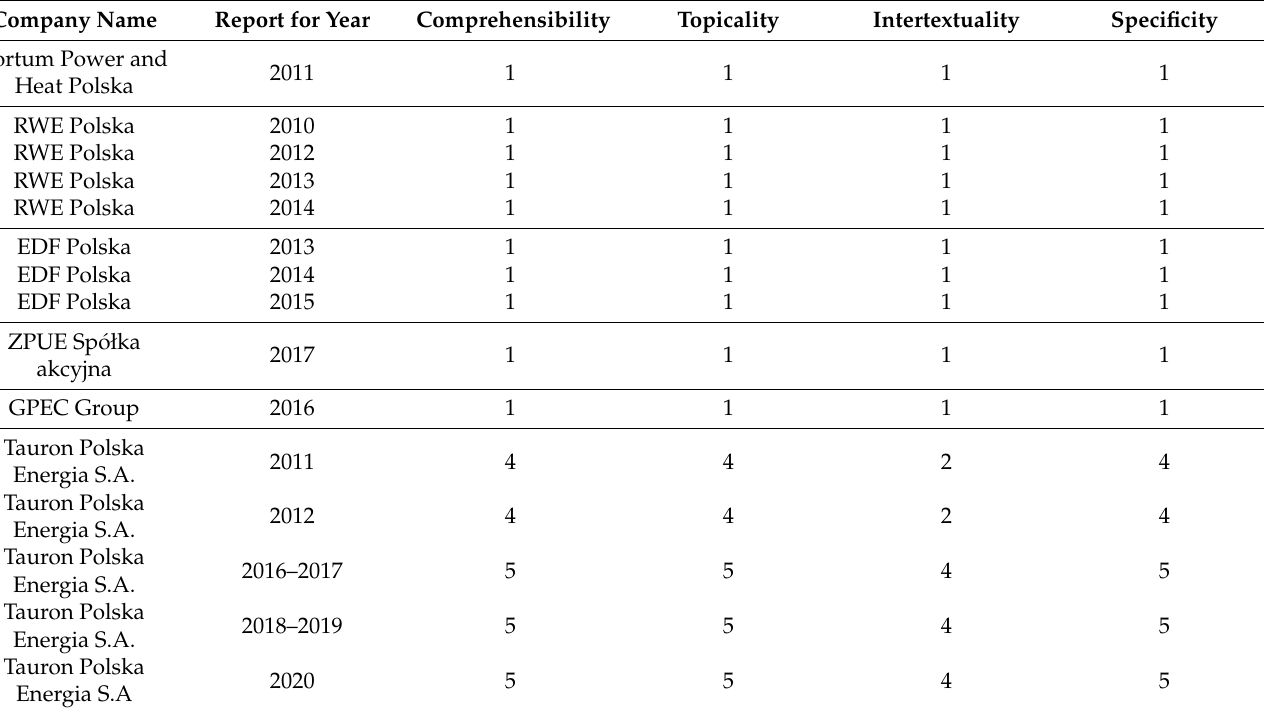
Table 9. Assessment of the ERMS information included in energy companies’ non-financial reports.